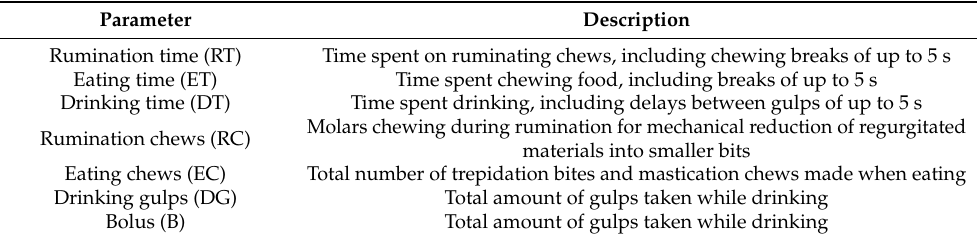
Table 1. Biomarkers of rumination behavior identified using real-time sensors and quantified using the RumiWatch noseband sensor (ITIN + HOCH GmbH, Fütterungstechnik, Liestal, Switzerland) and their descriptions